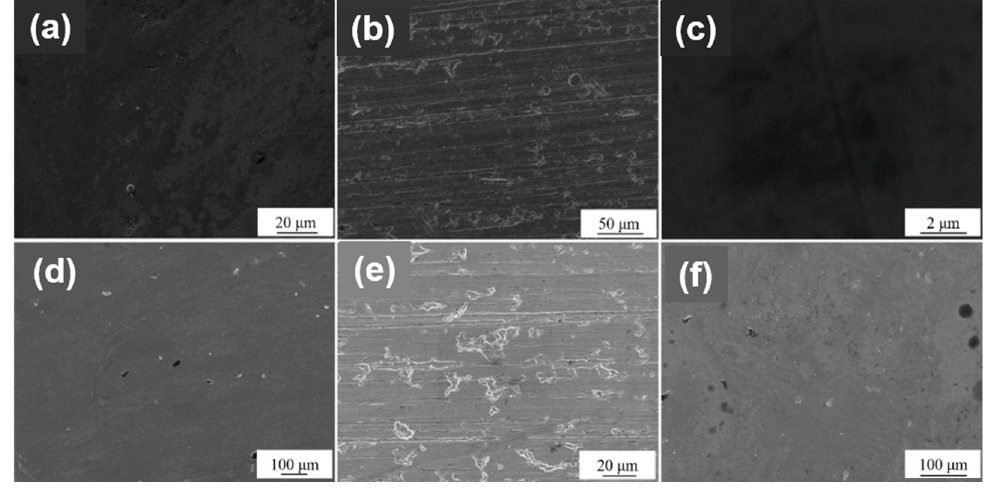
Figure 5. The SEM images of the salt-treated samples: TiN-1 ( a ), TiN-2 ( b ), TiN-3 ( c ), ZrN-1 ( d ), ZrN-2 ( e ), ZrN-3 ( f ).